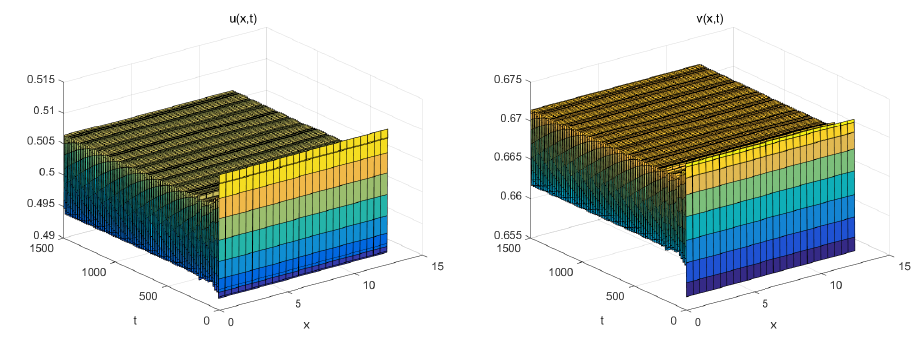
0.50 + 0.01 andv ( x ,0 ) ≈